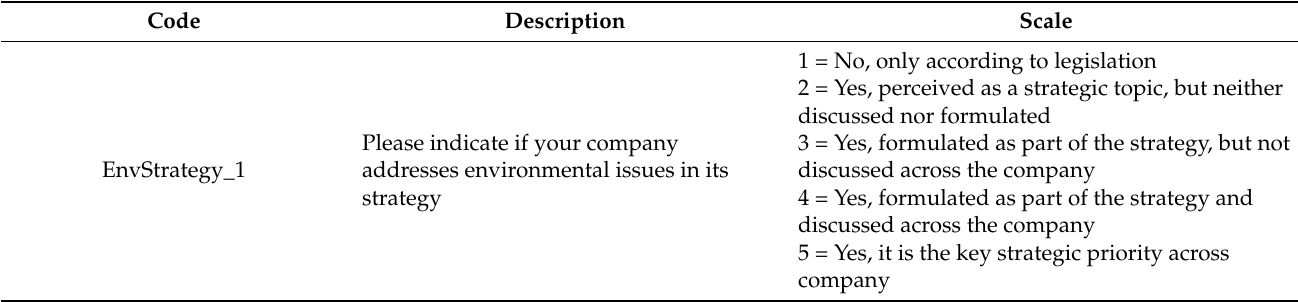
Table A1. Measurement